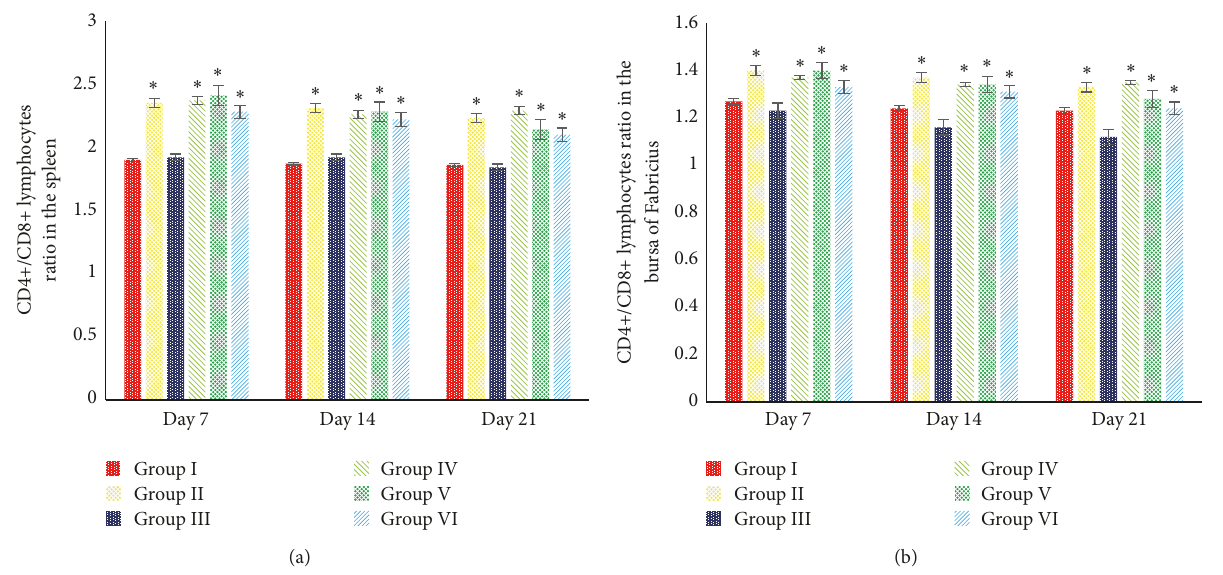
Figure 8: Effects of 5% SAP on the ratio of CD4+/CD8+ lymphocytes in the spleen (a) and BF (b) of broiler chickens fed a diet naturally contaminated with AF at 7, 14, and 21 days of age. ∗ The different superscript showed significantly different values ( P < 0.05).